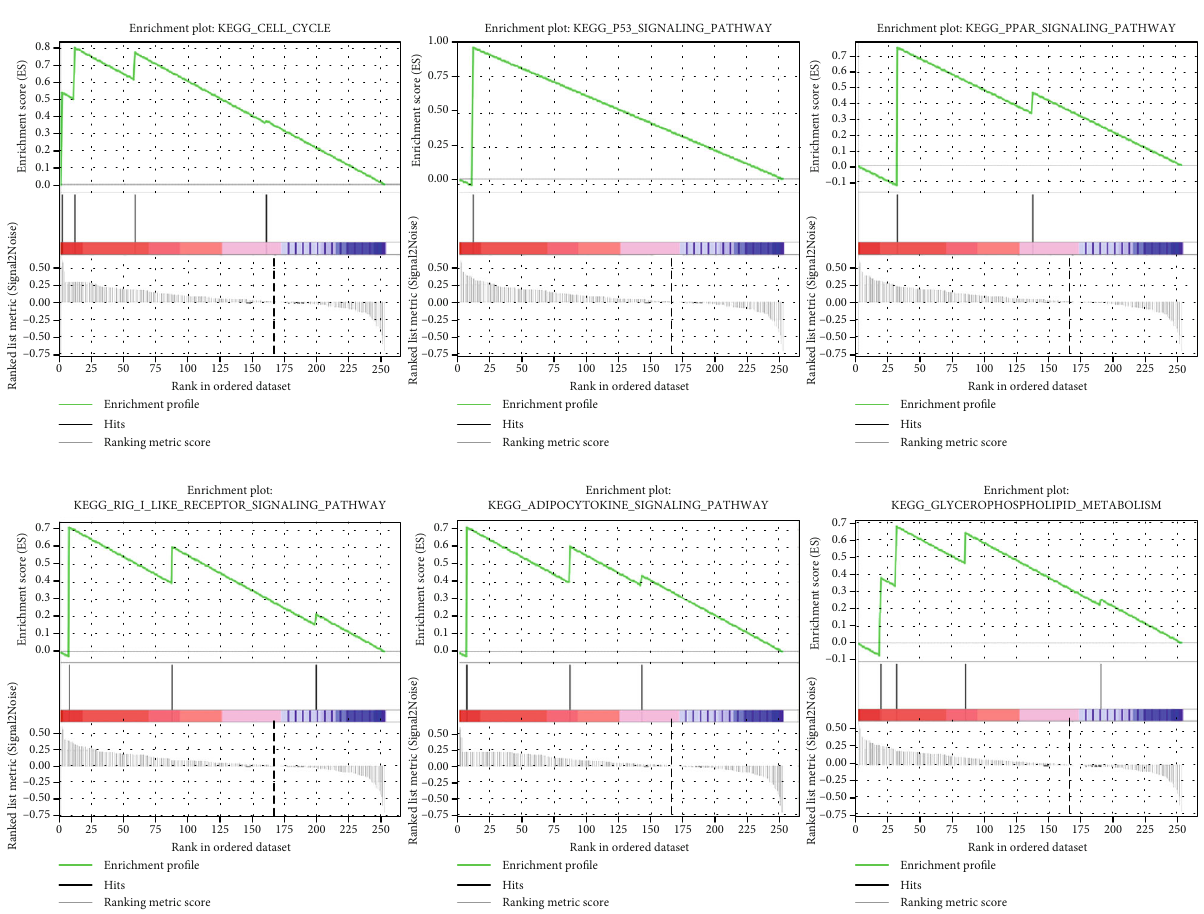
Figure 12: Gene set enrichment analysis (GSEA) using GSE32676. The six representative common KEGG pathway sets enriched in pancreatic cancer samples with a high expression of 12 overlapped